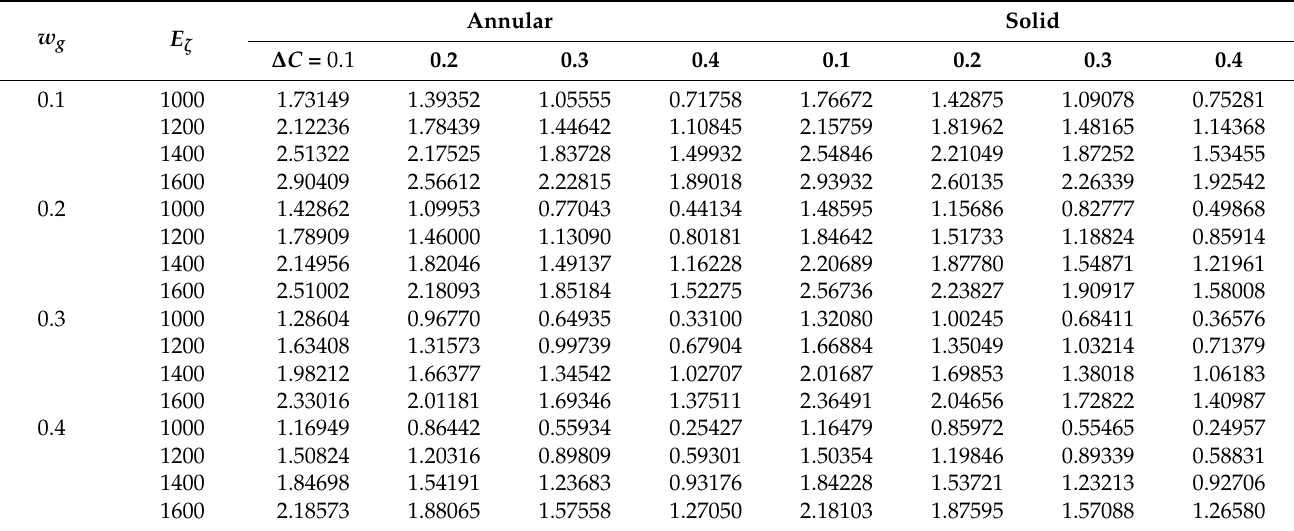
Table 3. Critical buckling temperature ∆ T cr of simply supported SGP annular and solid circular plates for different values of the moisture concentration ∆ C , graphene weight fraction w g and